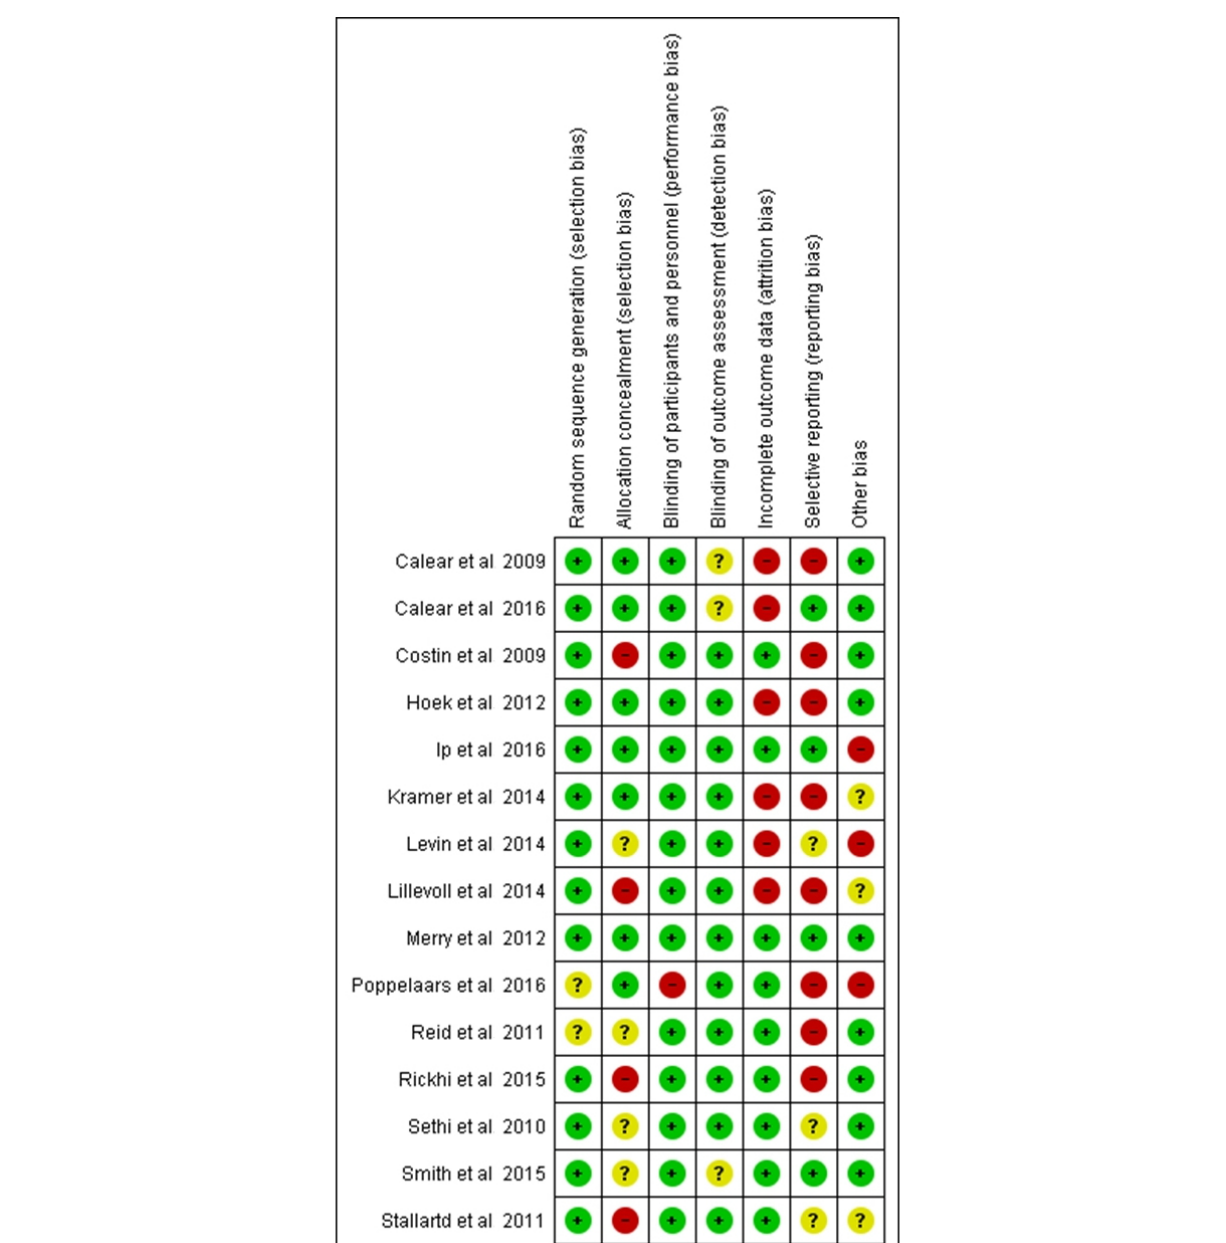
Figure 2. Risk of bias of studies included in the